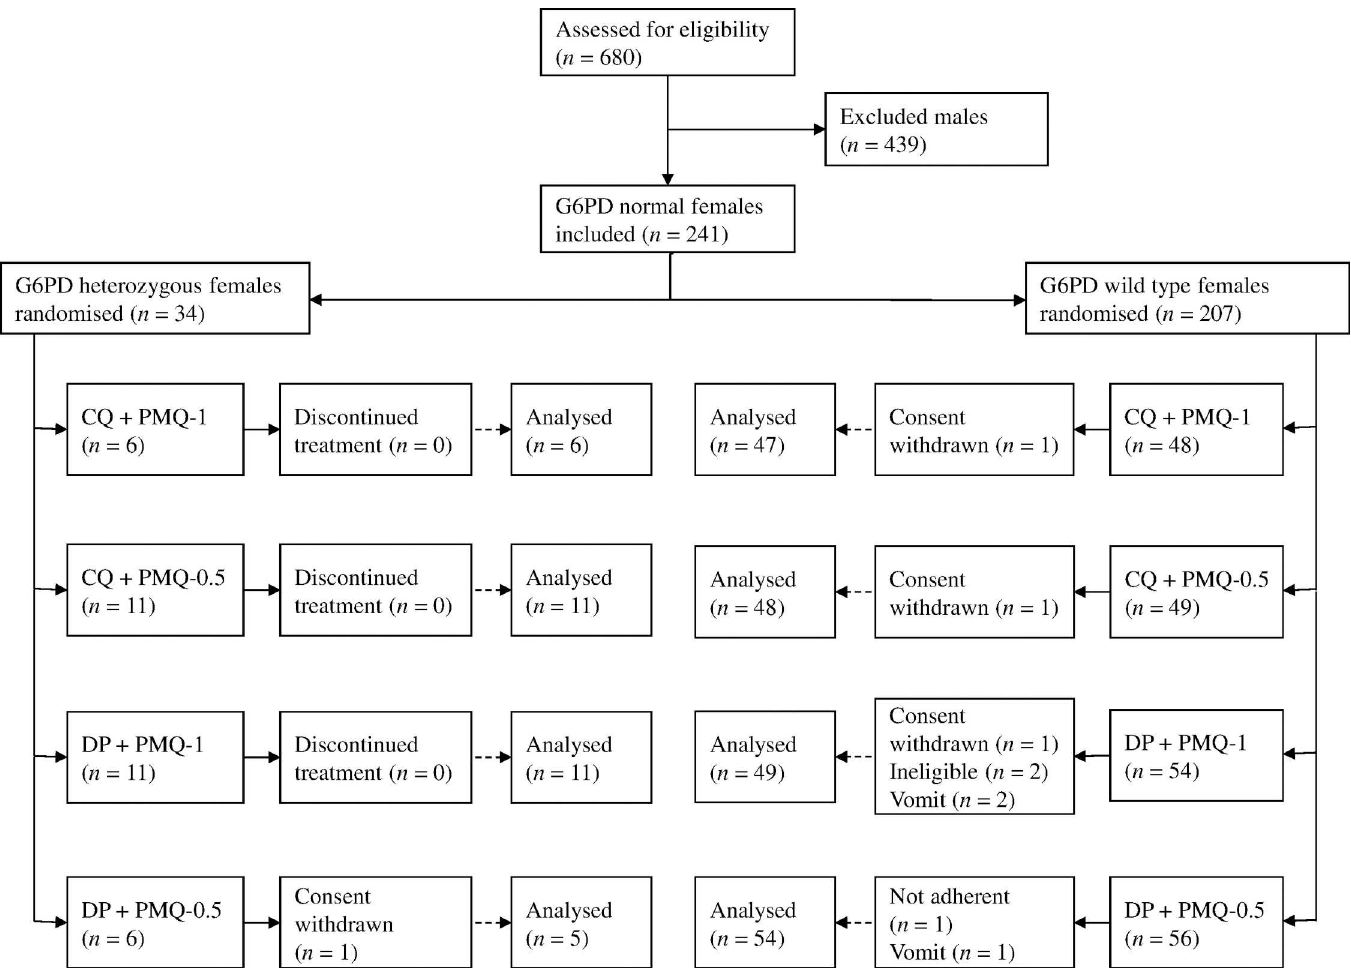
Fig 1. Trial diagram. CQ, chloroquine25 mg base/kg dividedover 3 d; DP, dihydroartemisinin7 mg/kg and piperaquine 55 mg/kg dividedover 3 d; PMQ-1, primaquine1 mg base/kg/d x 7 d; PMQ-0.5, primaquine0.5 mg base/kg/d x 14 d.